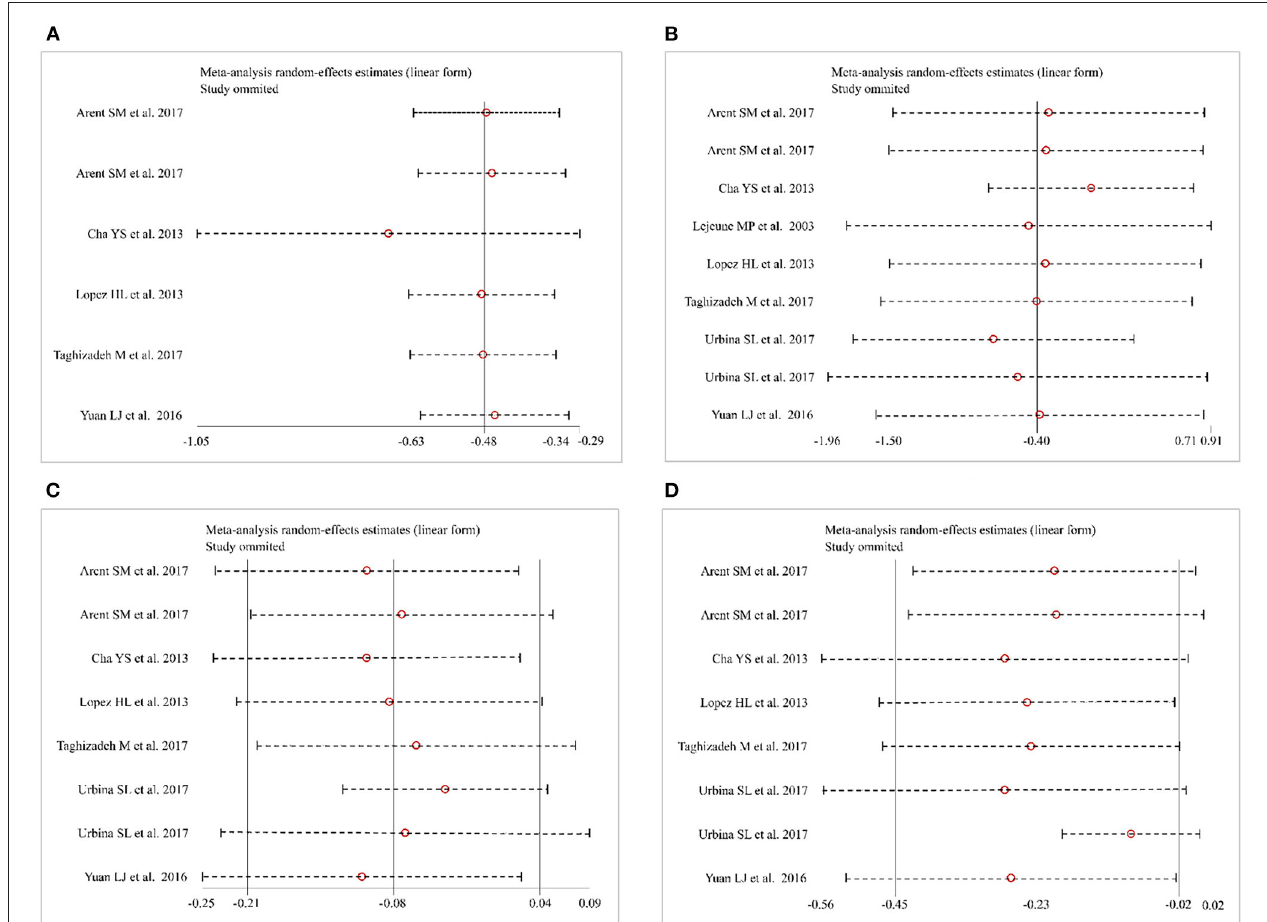
FIGURE 4 | Sensitivity analysis. (A) Total cholesterol (TC). (B) Triglycerides (TG). (C) High-density lipoprotein cholesterol (HDL-C). (D) Low-density lipoprotein cholesterol (LDL-C).